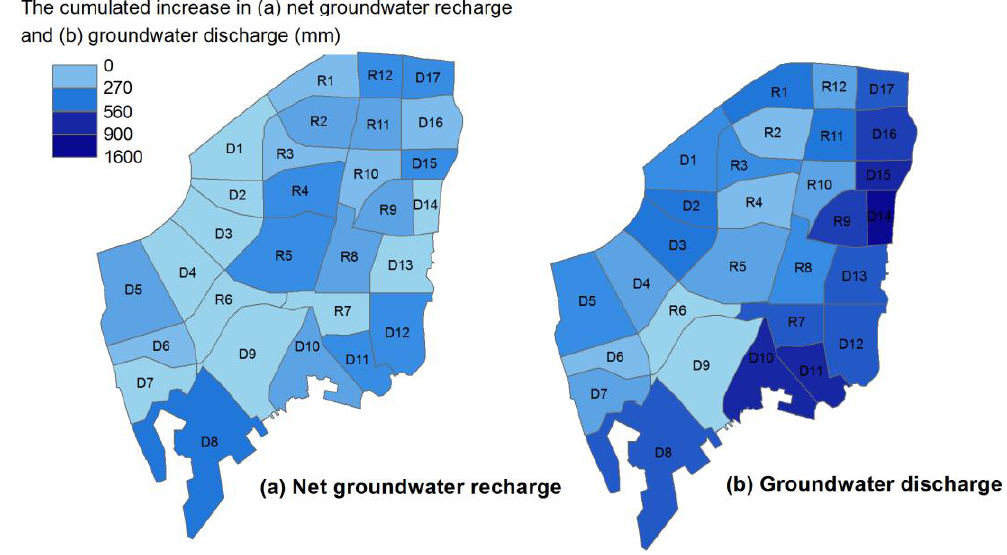
Figure 9. The 10-year cumulated increase in groundwater ( a ) net recharge and ( b ) discharge due to LID for the Scenario 1.